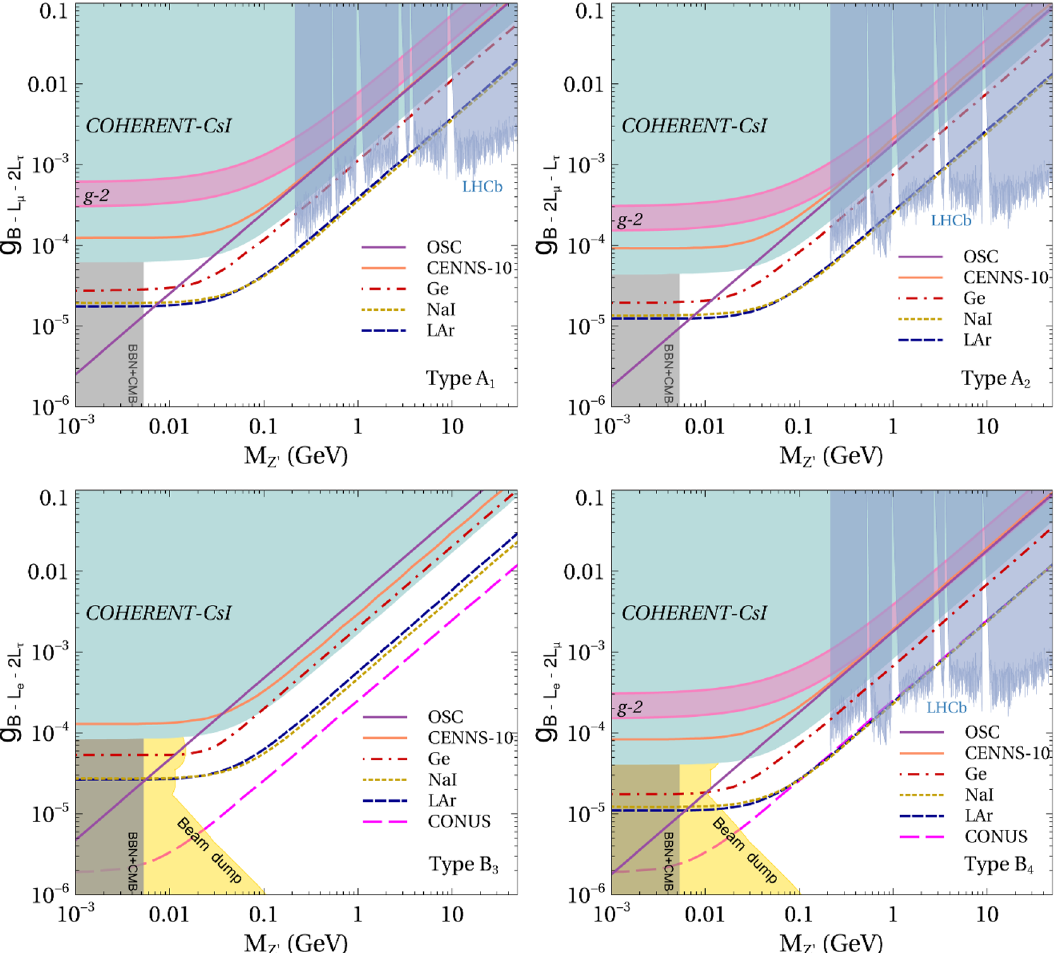
Figure 3 . Exclusion regions at 95% C.L. in the ( M Z 0 ; g 0 ) plane for the di(cid:11)erent models. The light- green shaded area corresponds to the constraint set by the current COHERENT measurement using a CsI detector [40], while the orange solid line comes from the recent COHERENT results using the CENNS-10 detector [42]. The solid purple line shows the limit from oscillation experiments [78]. The limits set by the future detectors setup from the COHERENT collaboration [85], namely, Ge, NaI, and LAr-1t are shown using the red dash-dotted, yellow dotted, and blue dashed lines, respectively. The limits from the CONUS reactor experiment [43] are shown by the magenta (long dashed) lines. The exclusion regions set by the beam dump experiments [86{95], BBN and CMB [96], and LHCb dark photon searches [97] are presented using color code yellow, gray and sky-blue regions, respectively. The pink shaded band corresponds to the region where the muon ( g (cid:0) 2) anomaly is explained [98] (see text for more details).